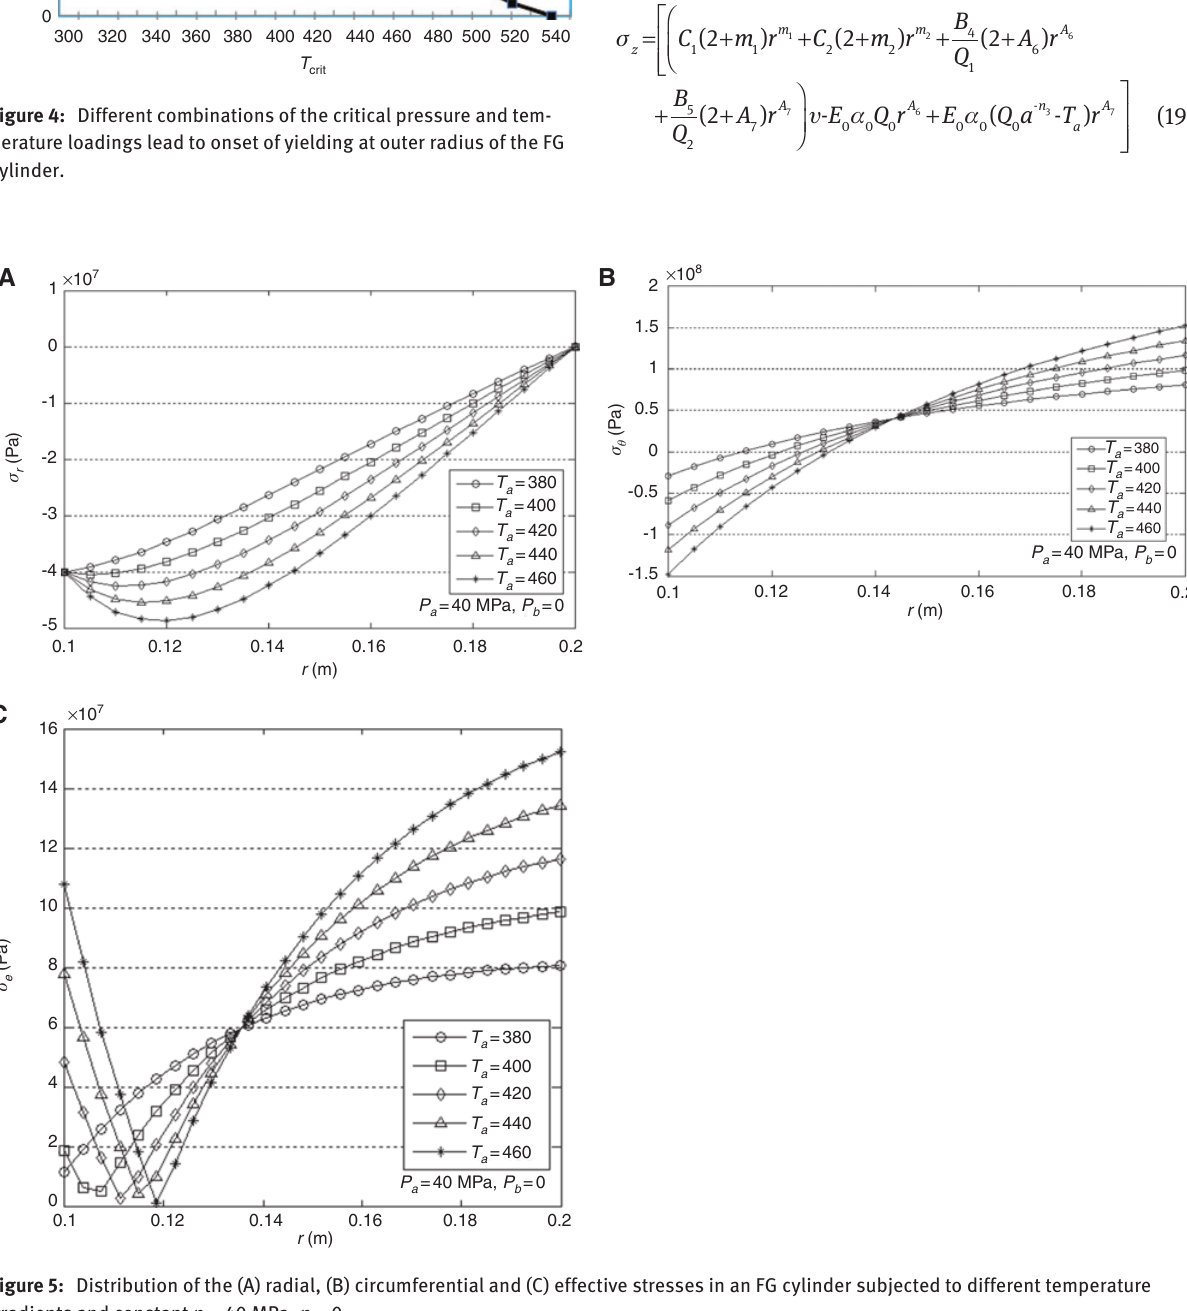
Figure 5: Distribution of the (A) radial, (B) circumferential and (C) effective stresses in an FG cylinder subjected to different temperature = 40 MPa, p = gradients and constant p a b